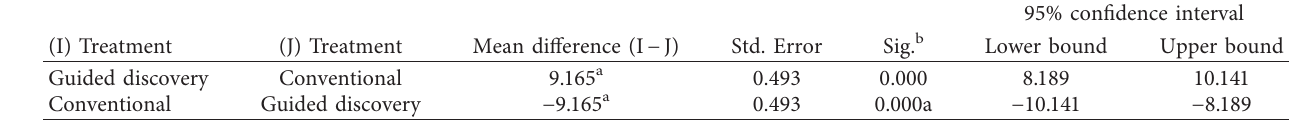
Table 4: Bonferroni’s postattitude rating by treatment.